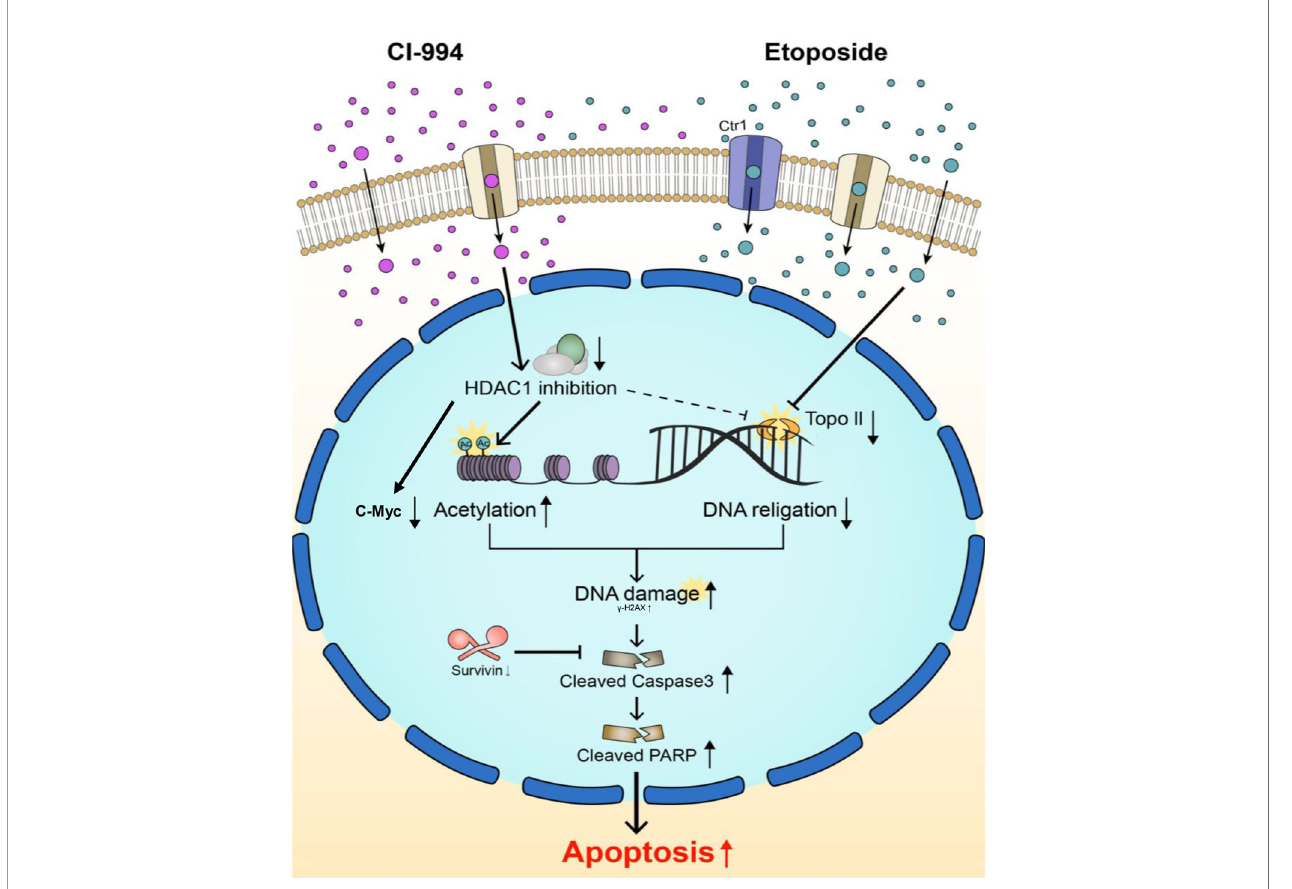
FIGURE 8 | Schematic diagram of two main targets of the combination treatment. Topo II and HDAC1 are known to interact with each other and modify each other ’ s activity. CI-994 and etoposide can pass through cell membranes using transporters and/or passive diffusion. CI-994 enters the cell, inhibits HDAC1 enzyme activity and increases histone acetylation, therefore activating cleaved Parp. CI-994 also reduced C-Myc, which was more effective in combination treatment with etoposide. CI-994 can also increase g – H2AX expression. Etoposide increases g -H2AX expression, which not only increases cleaved Parp levels but also decreases Survivin levels. The action of each of these drugs through the regulation of Topo II and Ac-H3 synergistically increases cleaved Parp levels and cleaved Caspase-3 levels, leading to the apoptosis of AT/RT